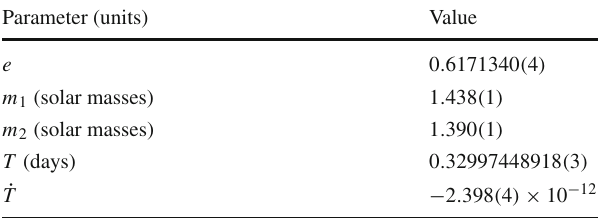
Table 1 Data from PSR 1913+16 [23] adapted to the present notation Parameter